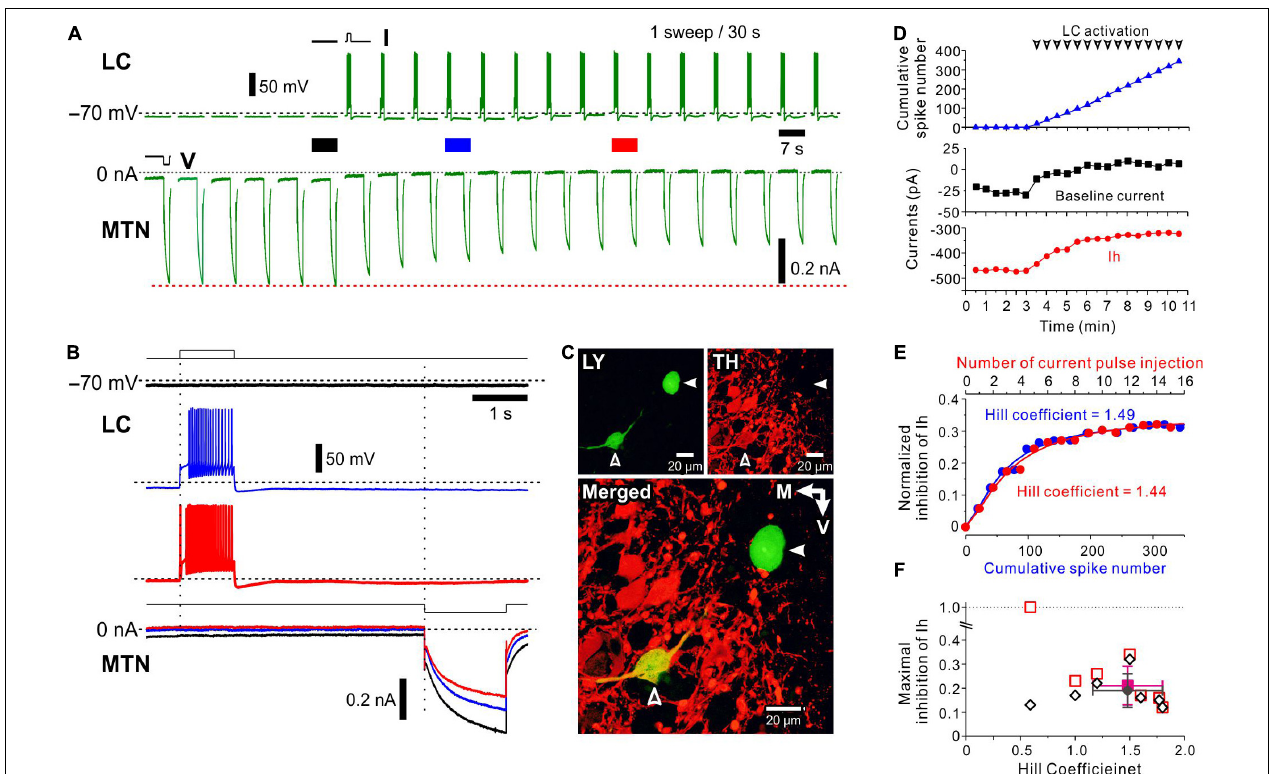
FIGURE 2 | Effects of spiking of an LC neuron on hyperpolarization-activated, cyclic nucleotide-gated HCN channel current (Ih) evoked in a simultaneously recorded MTN neuron. (A) Following recording of six control Ih evoked in an MTN neuron, a depolarizing current pulse was applied every 30 s to induce a spike train approximately at 20 Hz in an LC neuron (top). Ih was repeatedly evoked in the MTN neuron every 30 s (bottom). In response to repeated depolarizing current pulses, amplitudes of Ih gradually decreased. (B) Superimposed enlarged Ih responses evoked in the MTN neuron seen during the respective time periods indicated with black, blue and red solid bars in (A) (top). Enlarged voltage responses evoked in the LC neuron during the respective time periods indicated in (A) (bottom). (C) Identification of simultaneously recorded LC and MTN neurons with Lucifer yellow (open and filled arrowheads, respectively; top left). Confocal photomicrographs showing immunoreactivity for TH (top right). A merged image showing that TH immunoreactivity was observed in the LC neuron (open arrowhead) but not in the MTN neuron (filled arrowhead; bottom). (D) Plotting of time and baseline current amplitude (black square), Ih amplitude (red circle), and cumulative spike number (blue triangle) before and during activation of LC neurons. Arrowheads indicate spike trains. (E) Plotting of cumulative spike number/current pulse injection and normalized inhibition of Ih. The blue curve was obtained by the Hill equation fitting to the data points for cumulative spike number while the red curve was obtained by the Hill equation fitting to those for current pulse injection. (F) Plotting of the Hill coefficient (nH) and maximal inhibition of Ih ( n = 6). Filled diamond and square indicate mean values of nH and maximal inhibition in measured (open diamonds) and calculated (open squares) values,